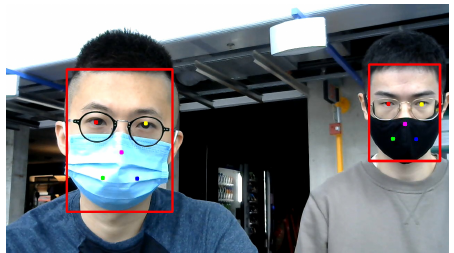
Figure 4. An example of multiple subjects’ faces (red bounding boxes) and facial landmarks (colored dots) detected by RetinaFace detector when they were wearing face